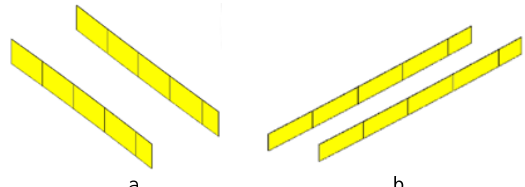
Figure 11. 3D models of the railing elements for: a: bridge 1; and b: bridge 2.